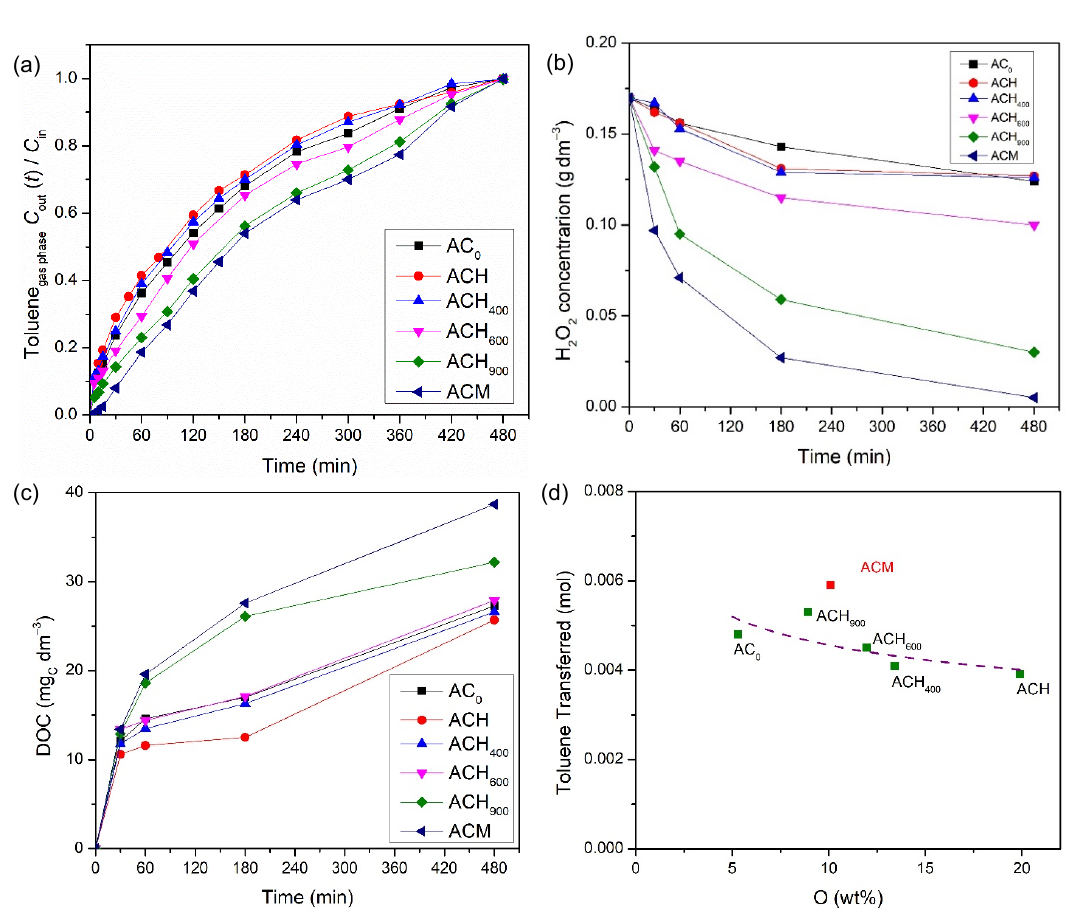
Figure 5. Effect of metal-free catalysts on the toluene concentration at the outlet of the bubble reactor ( a ), on the concentration of H 2 O 2 ( b ), and on the DOC concentration ( c ) in the liquid phase during wet peroxidation experiments; and correlation between the amount of toluene transferred and the oxygen content present on each modified activated carbon ( d ). Experimental conditions were as follows: pH 0 = 3.0, [metal-free catalyst] = 0.75 g dm − 3 , [H 2 O 2 ] = 0.005 mol dm − 3 , Q air = 0.15 dm 3 min − 1 . In order to determine the influence of the modified activated carbons’ surface chem- istry on the catalytic activity of the derived iron-based catalysts, several runs were per- formed using modified activated carbons impregnated with 2 wt.% of iron in the presence